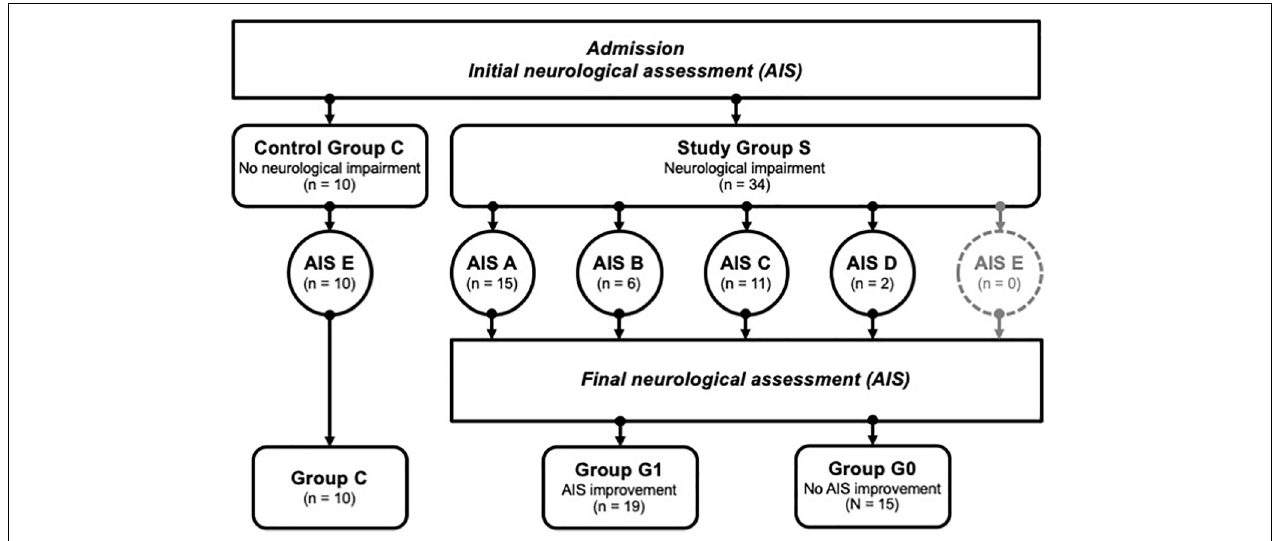
FIGURE 1 | Patient identification and allocation scheme. A set of n = 44 patients were successfully enrolled into the study, and divided into groups with no neurological impairment (Control Group C) vs. patients with neurological impairment (Study Group S). The latter group was subdivided further according to the severity of the symptoms using the AIS categories A-D, where A relates to the most severe condition. AIS improvement was assessed 3 months after enrolment, allowing a subdivision of S into group G1 (improvement) or G0 (no improvement). Group C; controls, group G1; patients with neurological remission, group G0; patients without neurological remission, AIS; American Spinal Injury Association (ASIA) Impairment